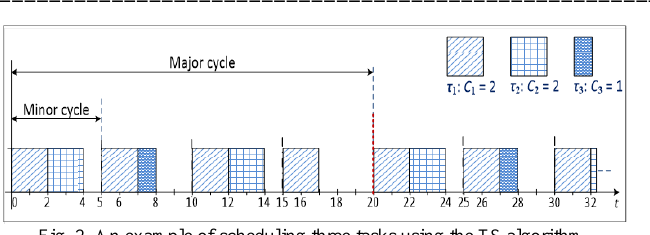
Fig. 2. An example of scheduling three tasks using the TS algorithm.